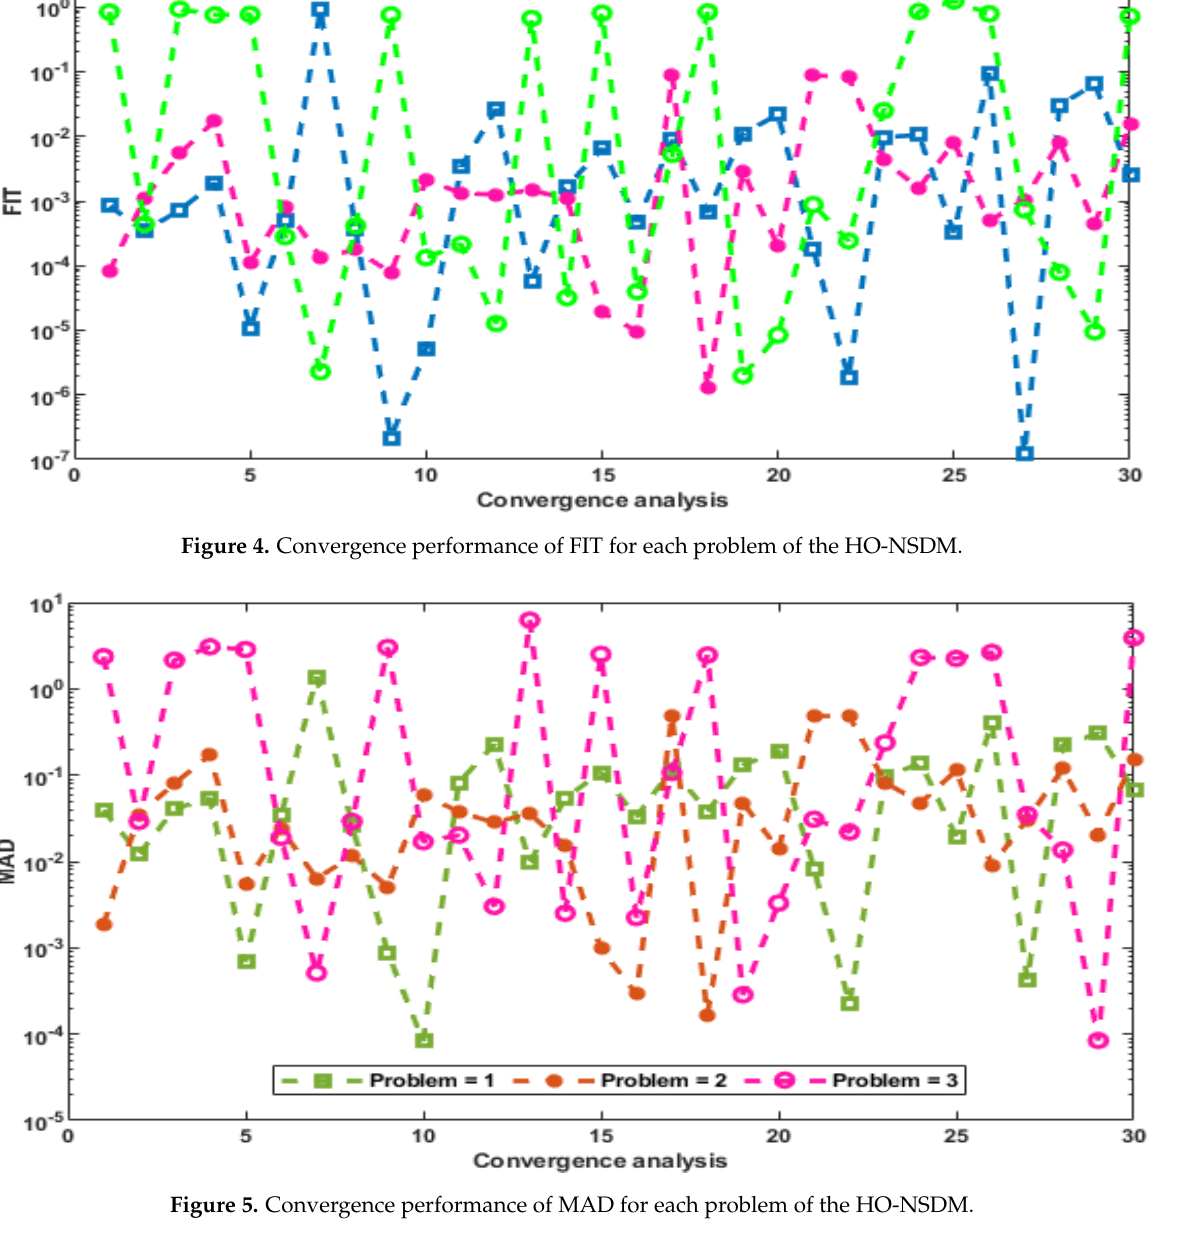
Figure 6. Convergence performance of TIC for each problem of the HO-NSDM.